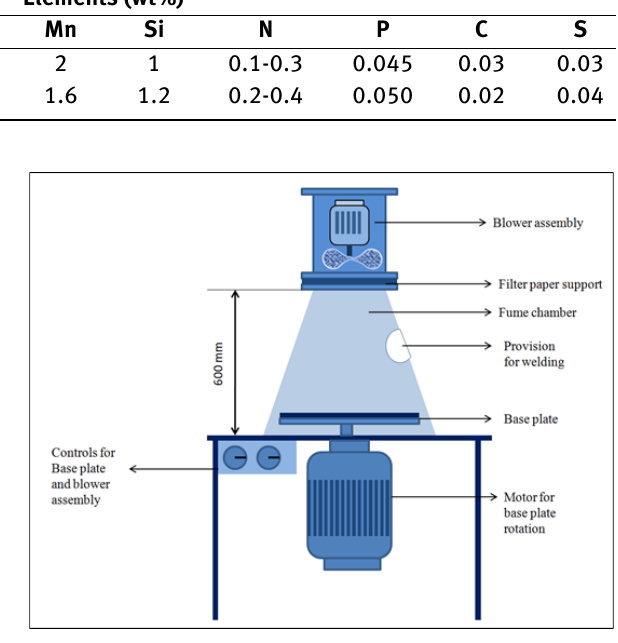
Figure 1: Schematic Diagram of fume collection